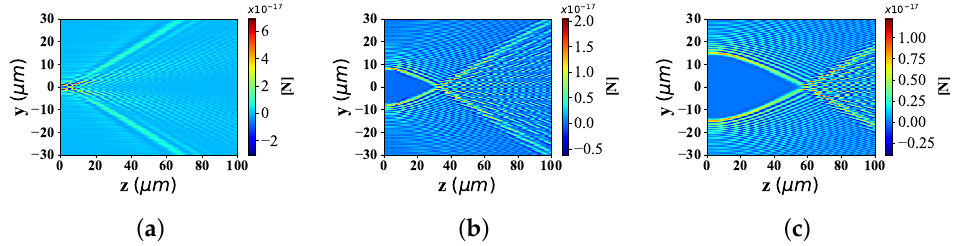
Figure 9. Distribution of F z under the interaction between the sphere and Bessel pincer light-sheets beam with different beam order l ( l = 5, 45, 85; α 0 = 0.5; radius is 0.1 µ m). ( a ) ł = 5; ( b ) ł = 45; ( c ) ł =